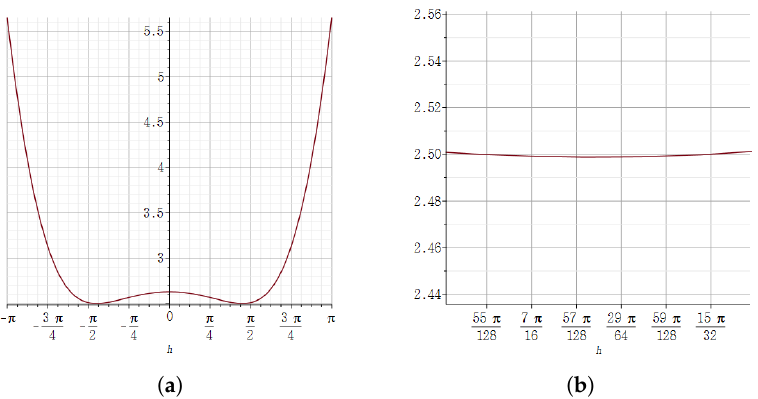
Figure 4. ( a ) The result of expressing the value of the relative error of the quaternion j -step derivative of cos z at z 0 on the vertical axis according to the size of the horizontal axis h using the Maple plot. ( b ) In the graph of ( a ), the result of zooming in about h near π error is to